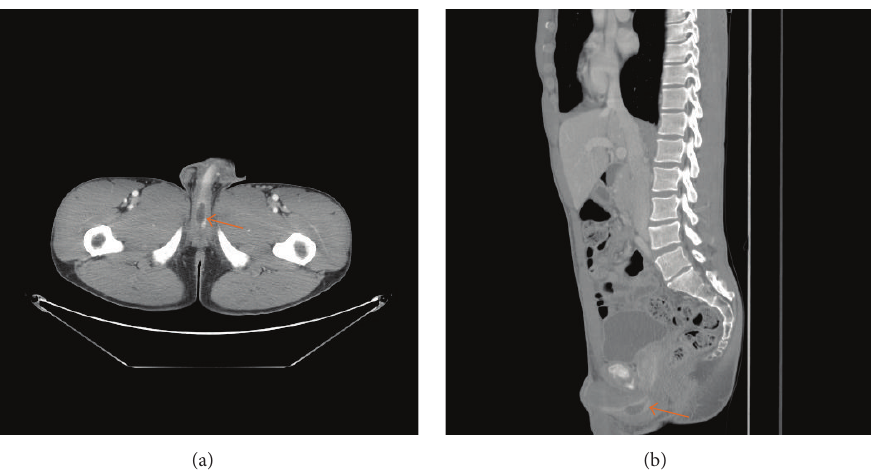
Figure 1: Representative (a) axial and (b) sagittal computed tomography images of the pelvis with contrast demonstrating Cowper’s syringocele (arrows).